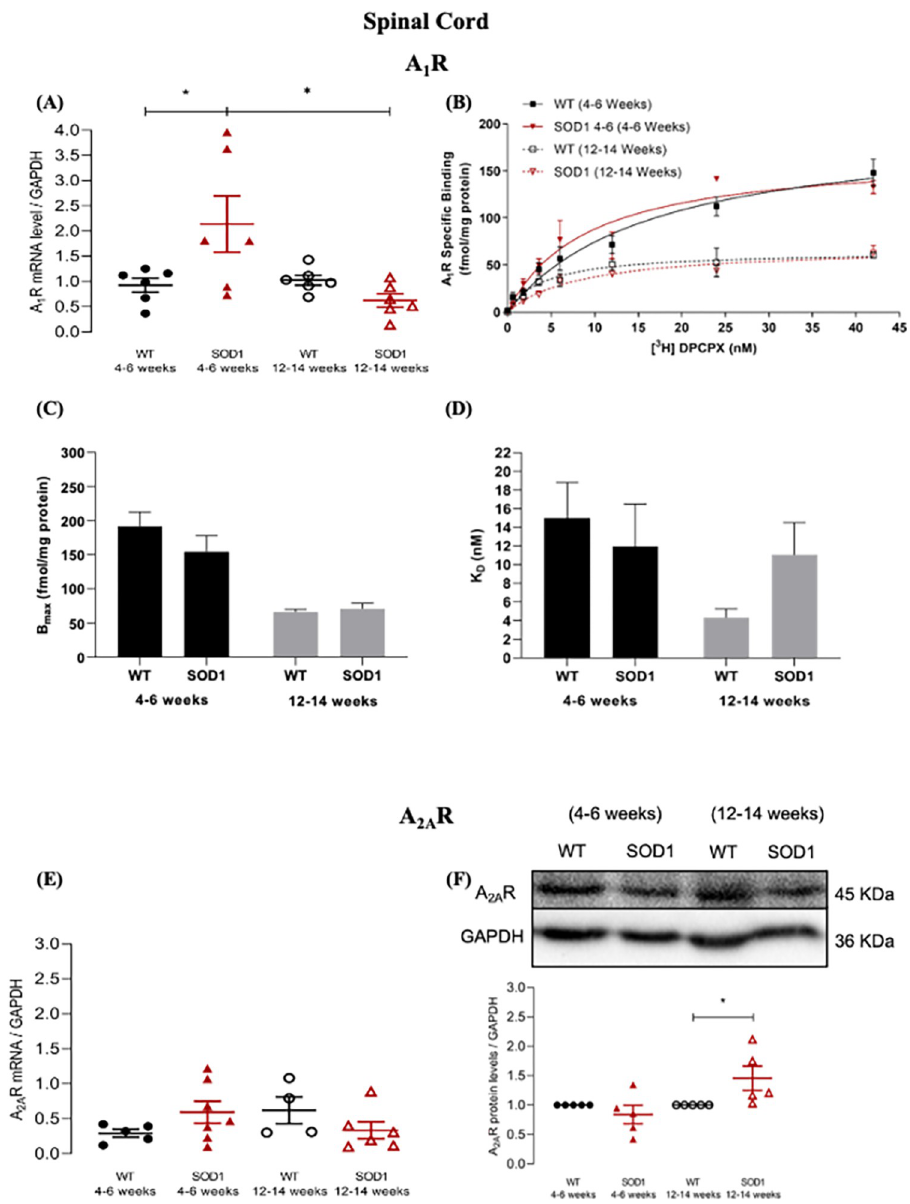
Fig 2. A 1 R and A 2A R mRNA expression and protein levels in the spinal cord of pre-symptomatic and symptomatic SOD1 G93A mice. (A) A 1 R mRNA expression in spinal Cord of pre-symptomatic (4–6 weeks old) and symptomatic (12–14 weeks old) SOD1 G93A and age-matched WT mice. The Y-axis represents the A 1 R transcript level of the normalized A 1 R/GAPDH ratio in each condition. (B) Saturation curve of A 1 R for pre-symptomatic and symptomatic SOD1 G93A and age-matched WT mice, in spinal cord. The Y-axis represents the specific binding of A 1 R expressed in fmol/mg protein plotted against increased concentrations of [ 3 H] DPCPX (nM) (abscissae). (C) Maximum density of A 1 R (Bmax) in spinal cord of pre-symptomatic and symptomatic SOD1 G93A and age-matched WT mice. (D) DPCPX equilibrium dissociation constant (K D ) expressed in nM, for pre-symptomatic and symptomatic SOD1 G93A and age-matched WT mice, in spinal cord. (E) A 2A R mRNA expression in spinal cord of pre- symptomatic and symptomatic SOD1 G93A and age-matched WT mice. The Y-axis represents the A 2A R transcript level of the normalized A 2A R/GAPDH ratio in each condition (F) A 2A R protein levels in spinal cord of pre-symptomatic and symptomatic SOD1 G93A and age-matched WT mice. The Y-axis represents the A 2A R/GAPDH ratios normalized to age-matched WT samples. Upper panels show representative immunoblots for each condition. Data are expressed as mean ± SEM (n = 4–7 animals for all conditions); � p < 0.05, two-way ANOVA with Holm-Sidak correction for multiple comparisons.